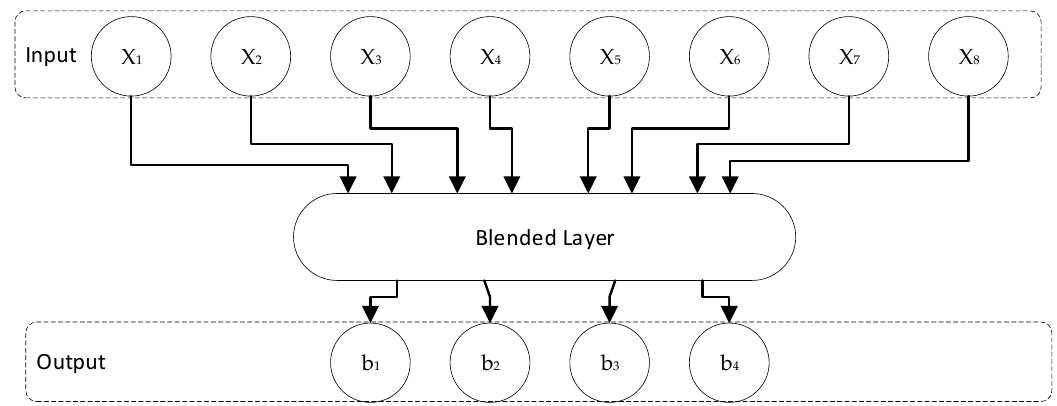
Figure 4. Structure diagram of the blended layer.